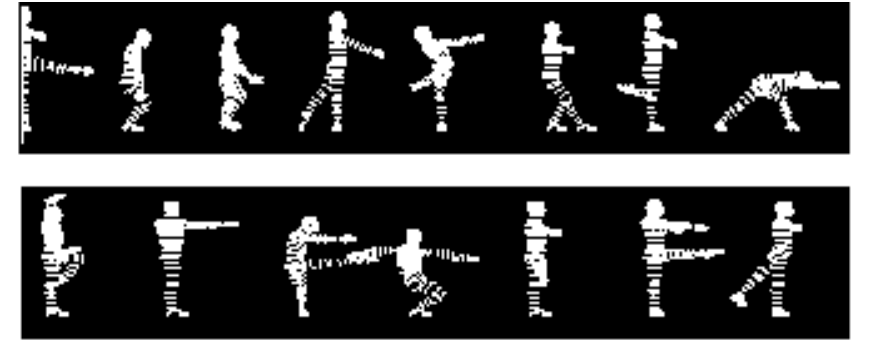
Figure 4.9. Existing Stances selected by Chance